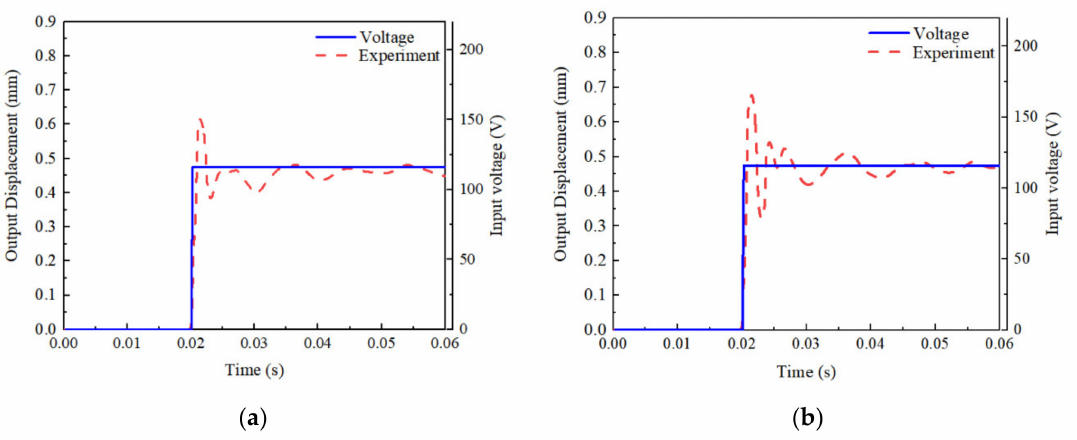
Figure 9. Step response of the spool; ( a ) at 20 ◦ C, ( b ) at 100 ◦